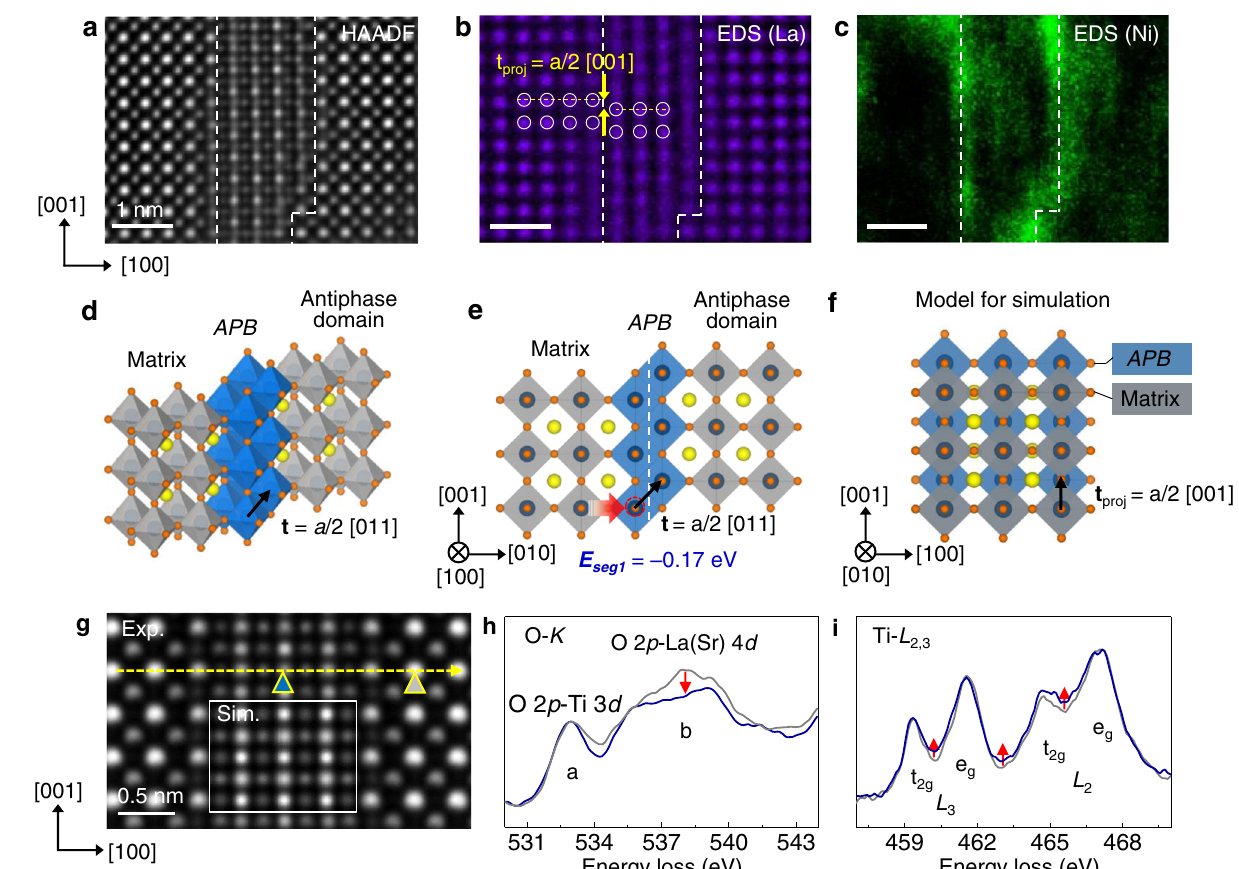
Fig. 2 | Nienrichment ofAPBs in the pristinenon-stoichiometric LSNT fi lm. a A STEM-HAADF image and the corresponding b La and c Ni EDS elemental map of a typical APB, indicating the Ni enrichment of the APB in the pristine non- stoichiometric 60nm thick fi lm. The atomic-resolution La EDS map con fi rms the proposed APD structure with the projected translation vector of a /2 [001]. d – f Atomic structure model of APB with the lattice translation vector of a /2 [011]. The yellow, navy, and orange spheres denote A-site (La/Sr), B-site (Ni/Ti) cations, and O ions, respectively. The gray octahedra represent the core-shared network in the matrix and APD; the blue octahedra represent the edge-shared network in the APB. The white dashed line denotes APB. The calculated segregation energy ( E seg1 )